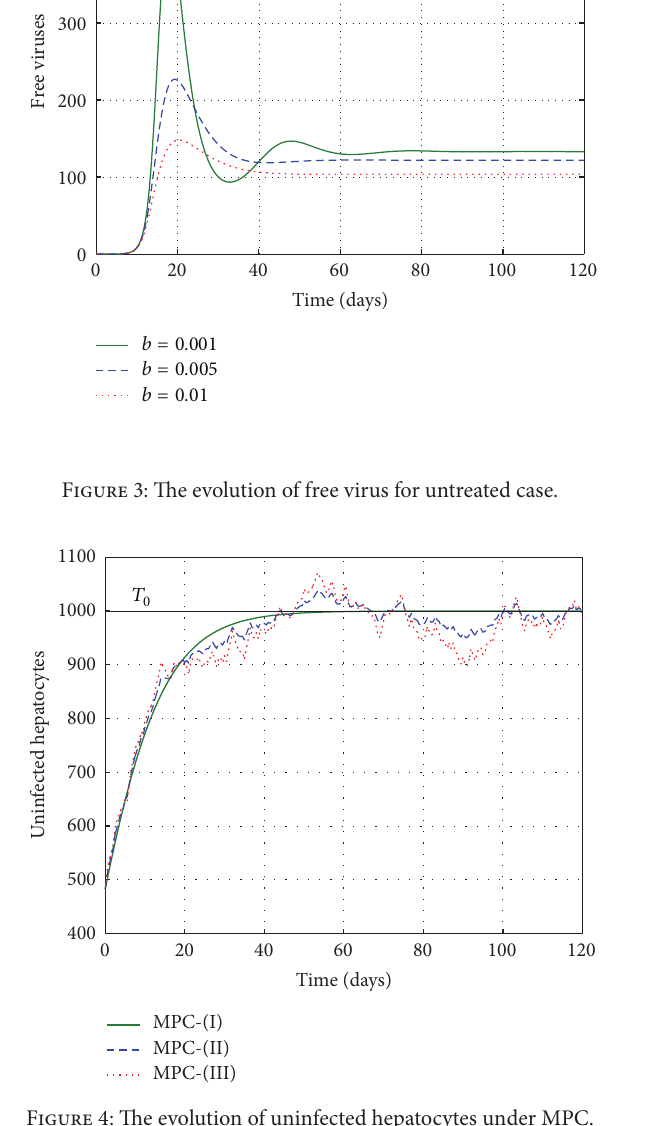
Figure 4: The evolution of uninfected hepatocytes under MPC.